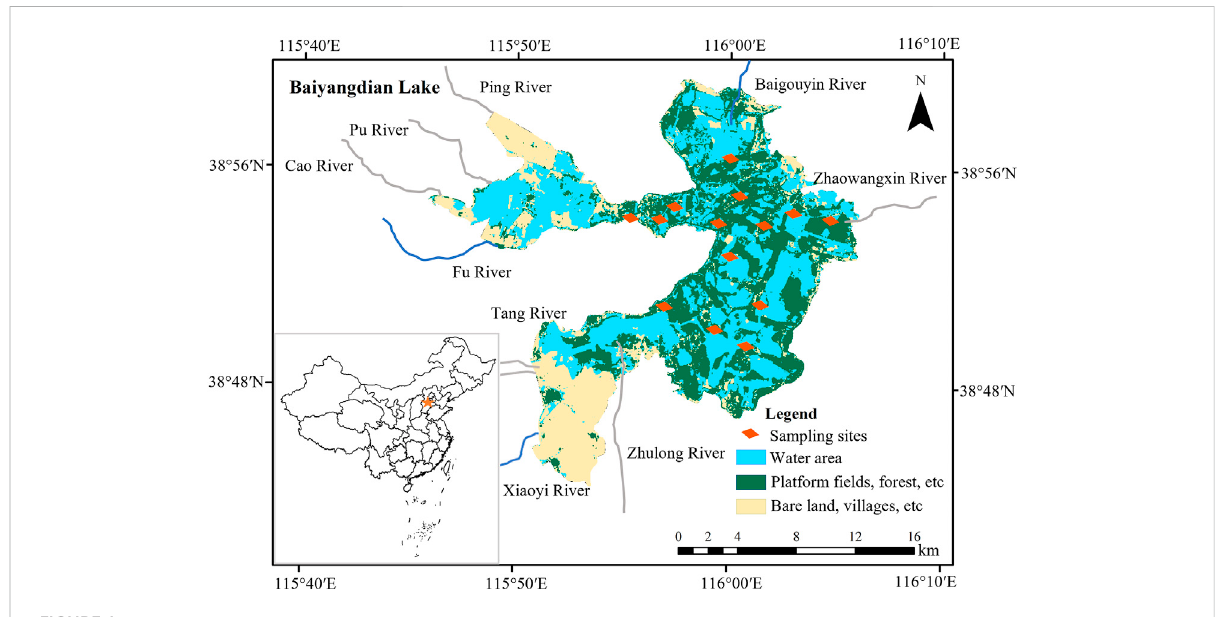
FIGURE 1 The locations of the study area, adjacent rivers, and sampling